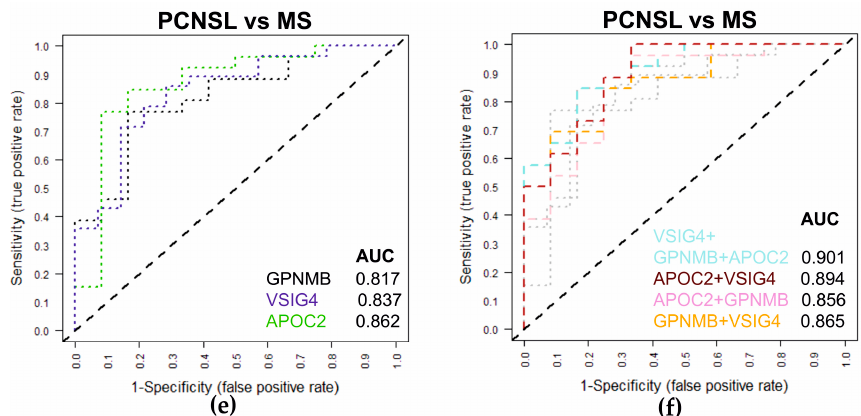
Figure 4. Diagnostic qualities of candidate peptide biomarkers determined by receiver operating characteristic (ROC) analysis. Comparison of peptide concentrations between samples from: ( a, b ) PCNSL and control patients, ( c, d ) PCNSL and ( e, f ) glioma patients and PCNSL and MS patients. Curves and area under the curve (AUC) values of single peptides ( a, c, e ) as well as curves of combinations of three or two markers (colored) as well as single peptides (grey, curves also in panel a) ( b, d, f ).